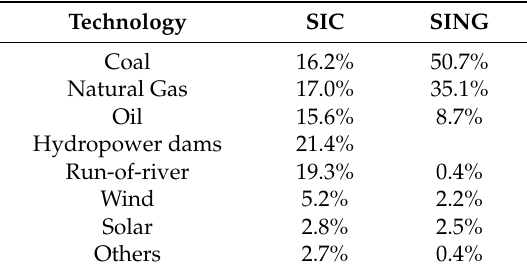
Table 1. Installed capacity participation by technology in 2015. SIC: Sistema Interconectado Central; SING: Sistema Interconectado del Norte